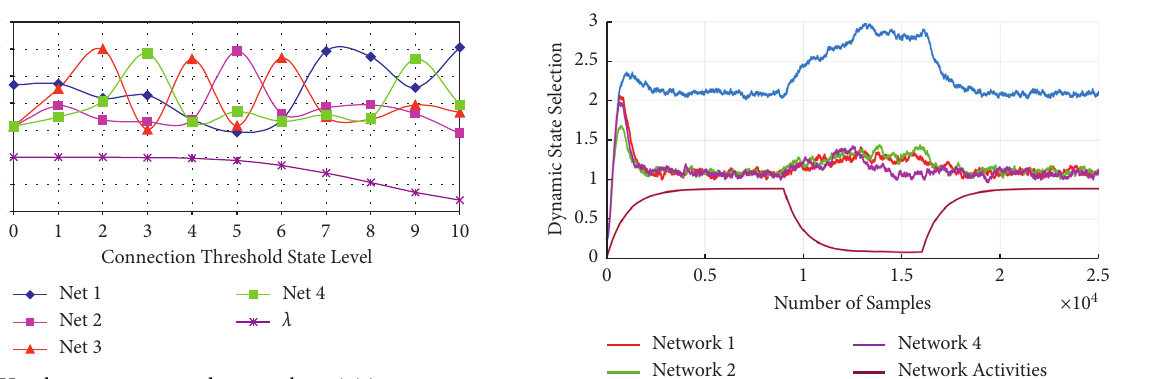
Figure 12: Handover process and network activities response (selection probability) to dynamic state selection as a function of threshold.